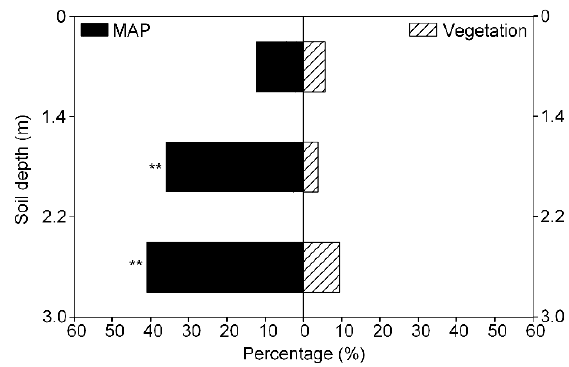
Figure 3. The proportion of mean annual precipitation (MAP) and vegetation types contributing to the variance of the log response ratio (LNRR) at different soil depths, based on the redundancy analysis (RDA). **, p < 0.01.